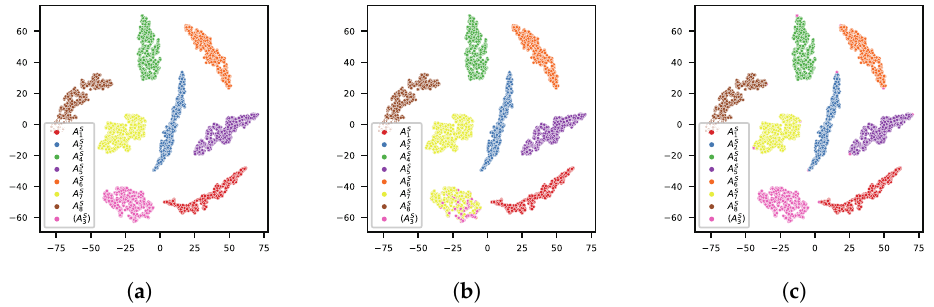
Figure 6. Visualizations of the true identity and predictions of the classifiers. A S denote that it is the unseen device. ( a ) True identity; ( b ) Predicitions of the OvA; ( c ) Predicitions of